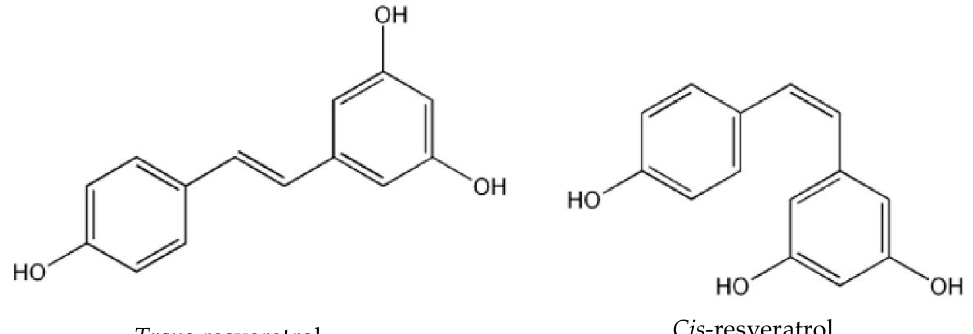
Figure 1. Chemical structure of trans - and cis -resveratrol.